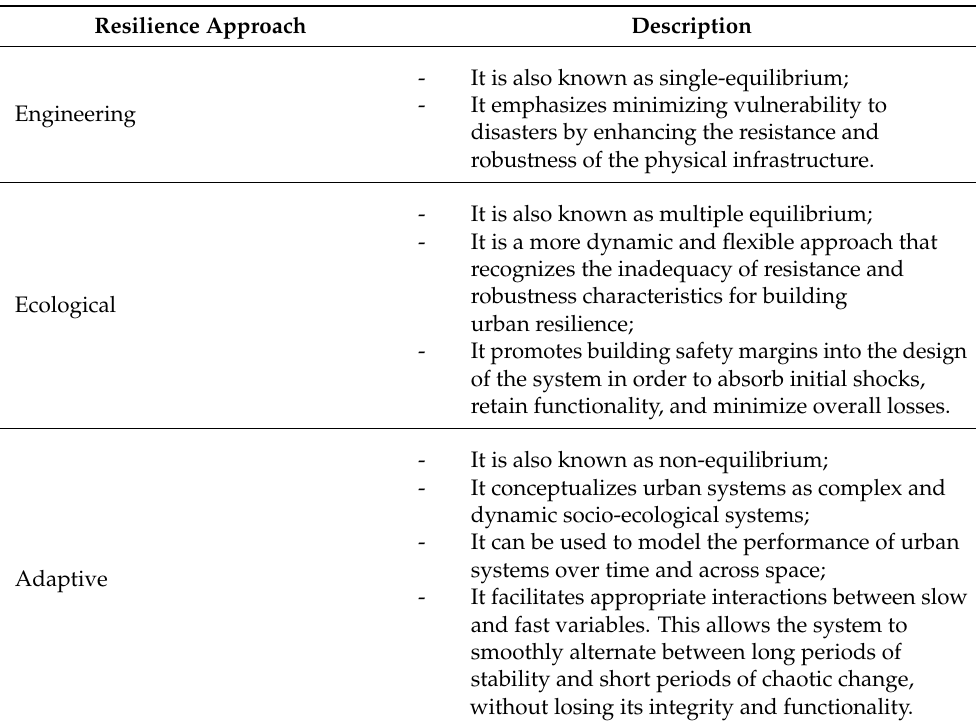
Table 1. Theoretical approaches to